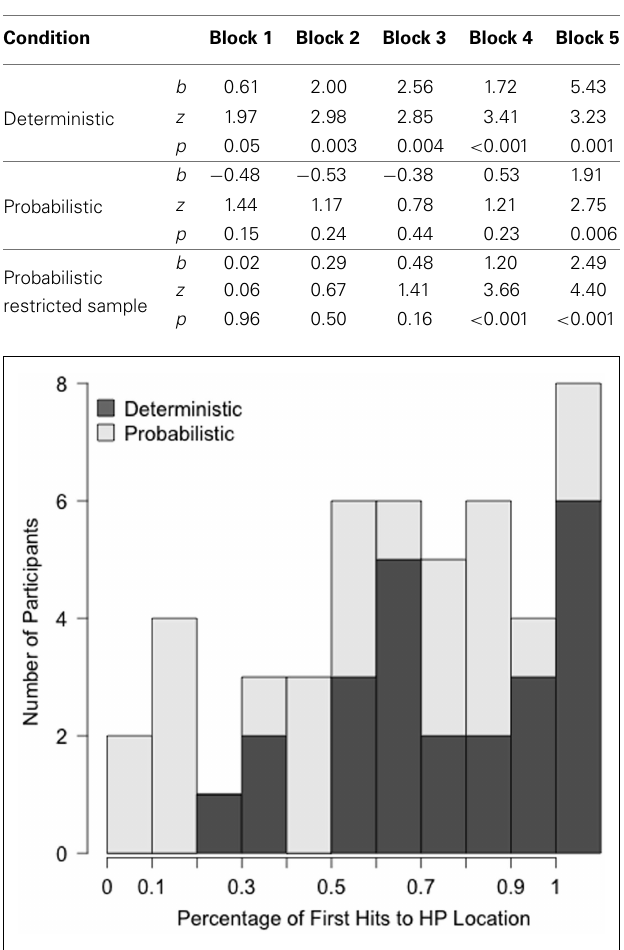
Table 2 | Results from intercept models for each experimental block testing whether infants anticipated the target more frequently at the HP location than expected by